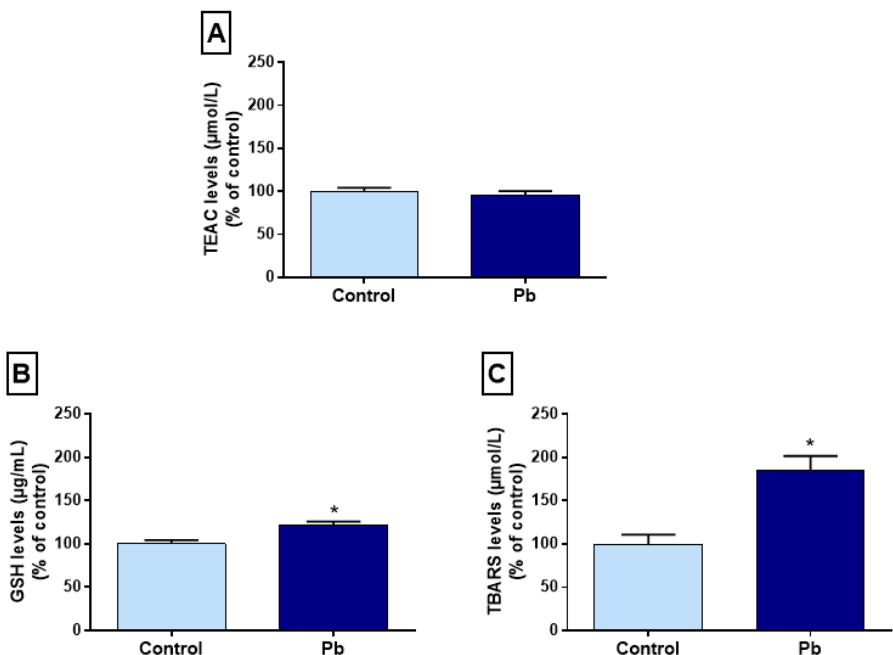
Figure 3. E ff ects of long-term exposure to lead acetate (Pb) on hippocampal oxidative biochemistry of Figure 3 . Effects of long-term exposure to lead acetate (Pb) on hippocampal oxidative biochemistry rats exposed from adolescence to adulthood, expressed as percentage of control. ( A ) Trolox equivalent a Accession ID according to the Uniport.org database. Positive and negative values of fold change of rats exposed from adolescence to adulthood, expressed as percentage of control. ( A ) Trolox antioxidant capacity (TEAC); ( B ) glutathione (GSH); ( C ) thiobarbituric acid reactive substances (TBARS) indicate up- and downregulated proteins, respectively. Signs of + or − indicates exclusive expression equivalent antioxidant capacity (TEAC); ( B ) glutathione (GSH); ( C ) thiobarbituric acid reactive levels. * p < 0.05 compared to the control group (Student’s t -test). in the Pb group and the control group, respectively. Results of the comparison between the Pb group substances (TBARS) levels. * p < 0.05 compared to the control group (Student's t-test). and the control group. The hippocampal proteomic analysis identified a total of 252 proteins in different status of expression. Of these, 42 were identified only in the control group, while 51 were expressed only in the group exposed to Pb. The total of 159 proteins had altered expression, in which 108 were according to their biologic processes through gene ontology (figure 4), being the five most affected processes related to neuron projection morphogenesis (22%), dendrite development (9%), regulation of axonogenesis (7%), glycolytic process (6%) and hippocampus development (5%). In Table 1 we highlighted the proteins used in the discussion and the complete result is available on supplementary material (Table S1). Table 1. Identified proteins with expression significantly altered in the hippocampus of rats of exposed group (Pb) vs. Control.